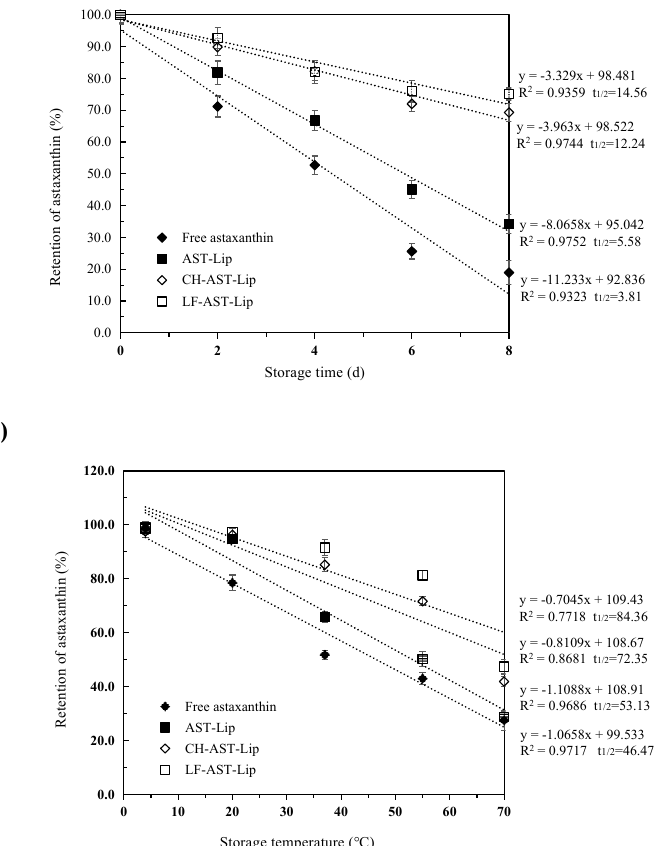
Figure 6. ( a ) Retention rate of astaxanthin in different samples under different storage time ( b ) Retention rate of astaxanthin in different samples under different storage temperatures.